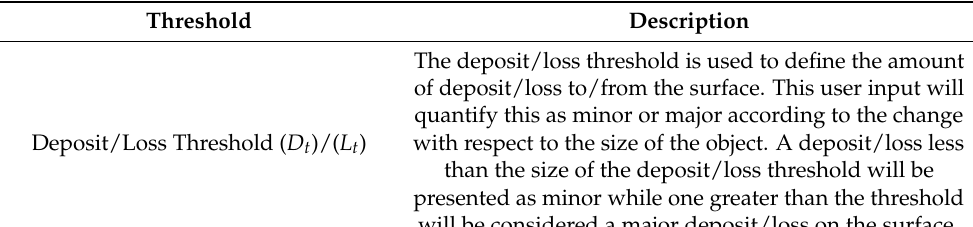
Table 2. User input thresholds to the segmentation method.